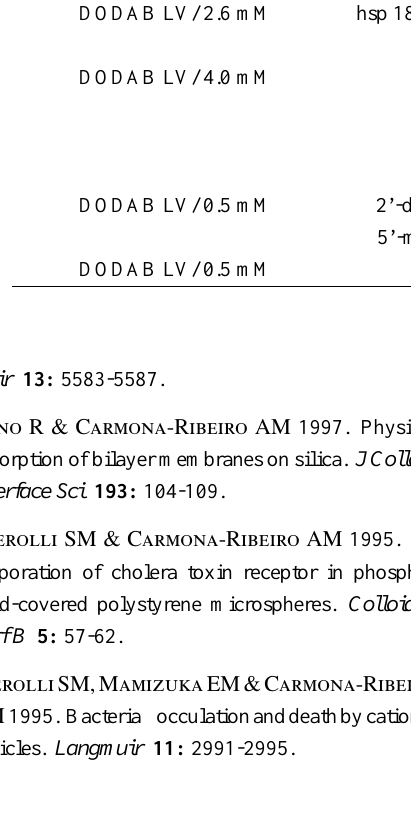
Incorporation (%) of a variety of biomolecules onto cationic DODAB liposomes. Adapted from Tsuruta et al . 1997, Carvalho & Carmona-Ribeiro 1998, Kikuchi et al . 1999. Liposome type and